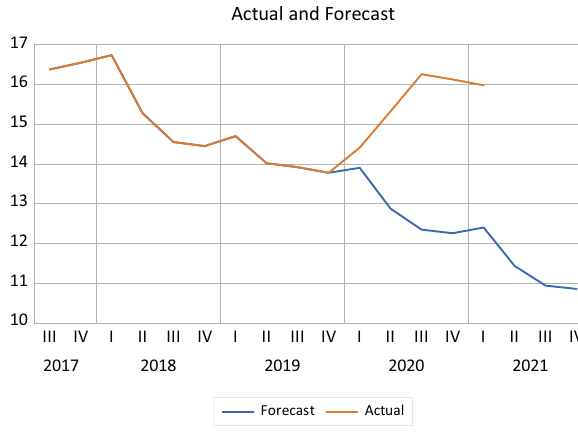
Figure 2: Unemployment rate forecast in normal times and actual rate.